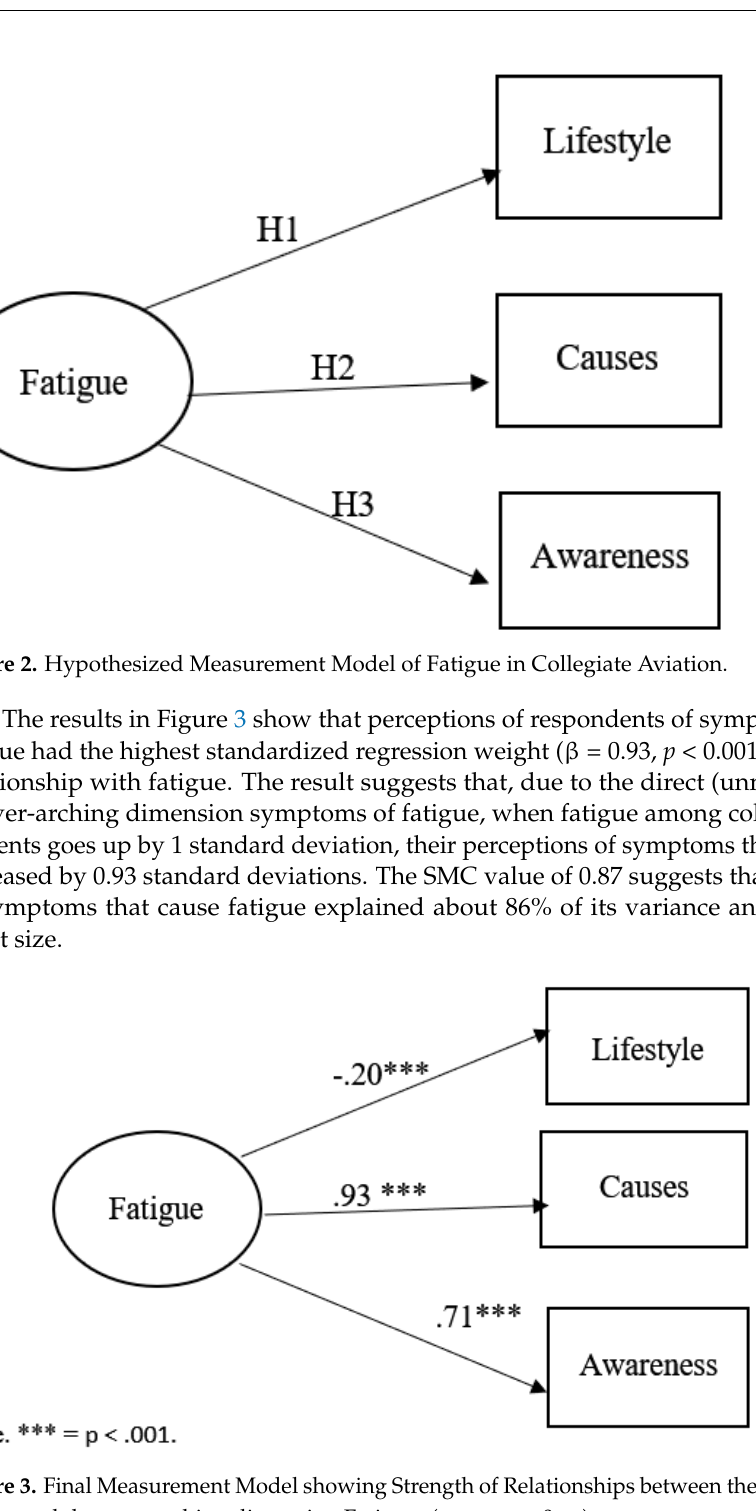
Figure 3. Final Measurement Model showing Strength of Relationships between the Three underlying factors and the over-arching dimension Fatigue. (.xx means